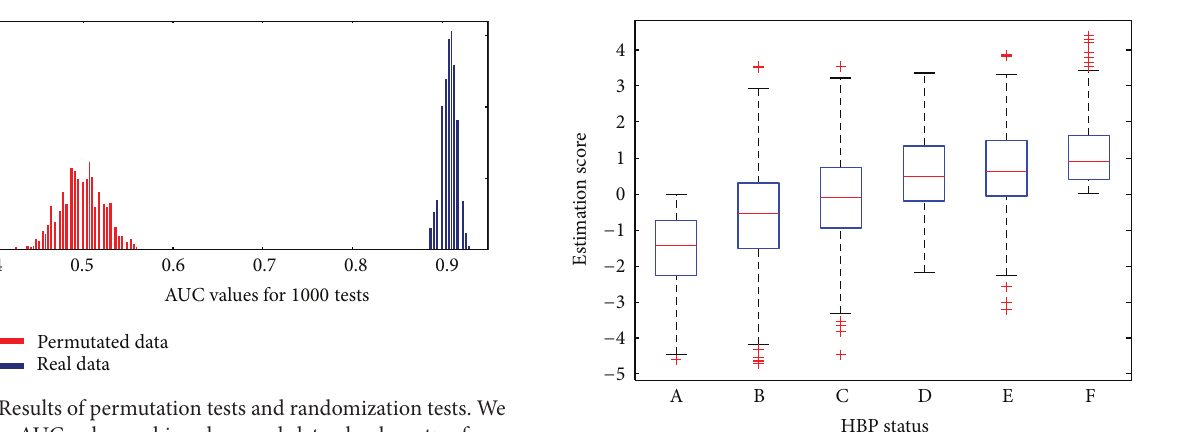
Figure 4: Results of permutation tests and randomization tests. We see that the AUC values achieved on real data clearly outperform those on permutated data, which suggests that the models have a good performance. The deviation of the AUC values on real data is small, which suggests that the performance of the proposed method is quite stable against random variations.